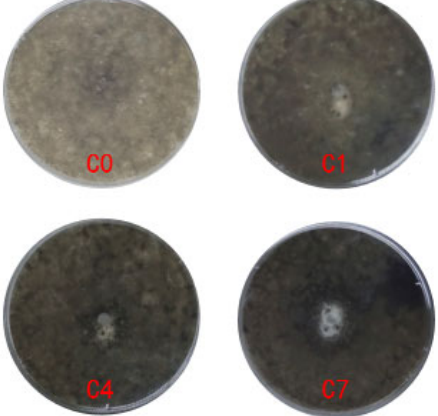
Figure 2. The real e ff ect of antimildew of each coating.